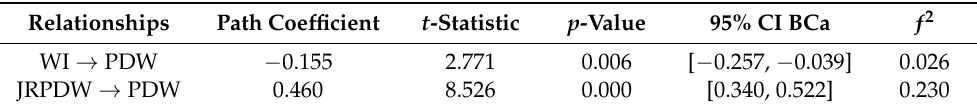
Table 6. Structural model